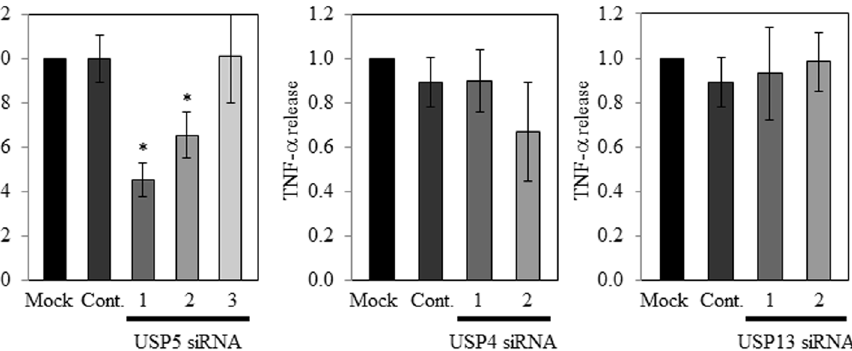
Figure 2. TNF- a release from DUB siRNA-knockdown cells. Amounts of TNF- a and from RBL-2H3 cells treated by DUB siRNA were determined by ELISA. Each value represents mean 6 standard deviation of triplicate determinations. The significance of differences from each control value was calculated using the Student’s t-test (*p , 0.05).